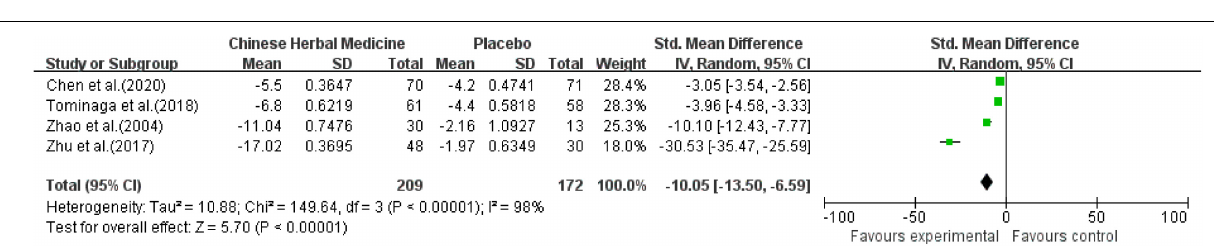
FIGURE 5 | Meta-analysis of total effective rate of CHM vs. western medicine group.